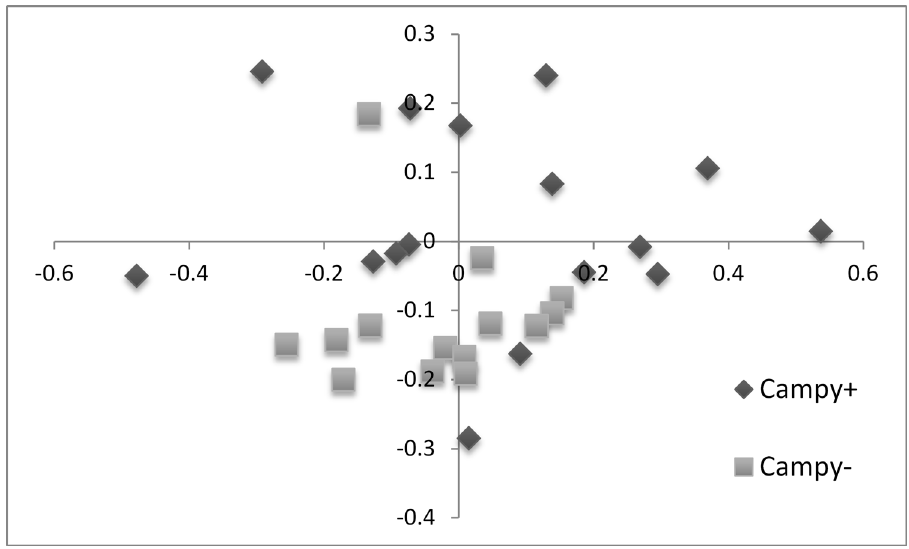
Fig 3. NMDS plot illustrating the chicken microbiome beta-diversity according to C . jejuni status. Each point represents a single chicken caecal microbiome; based on a subsample of 898 OTU.